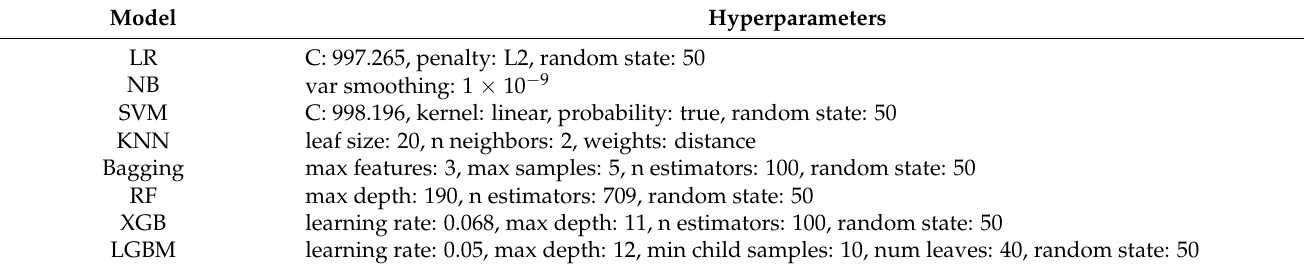
Table 2. Hyperparameters used for training each machine learning